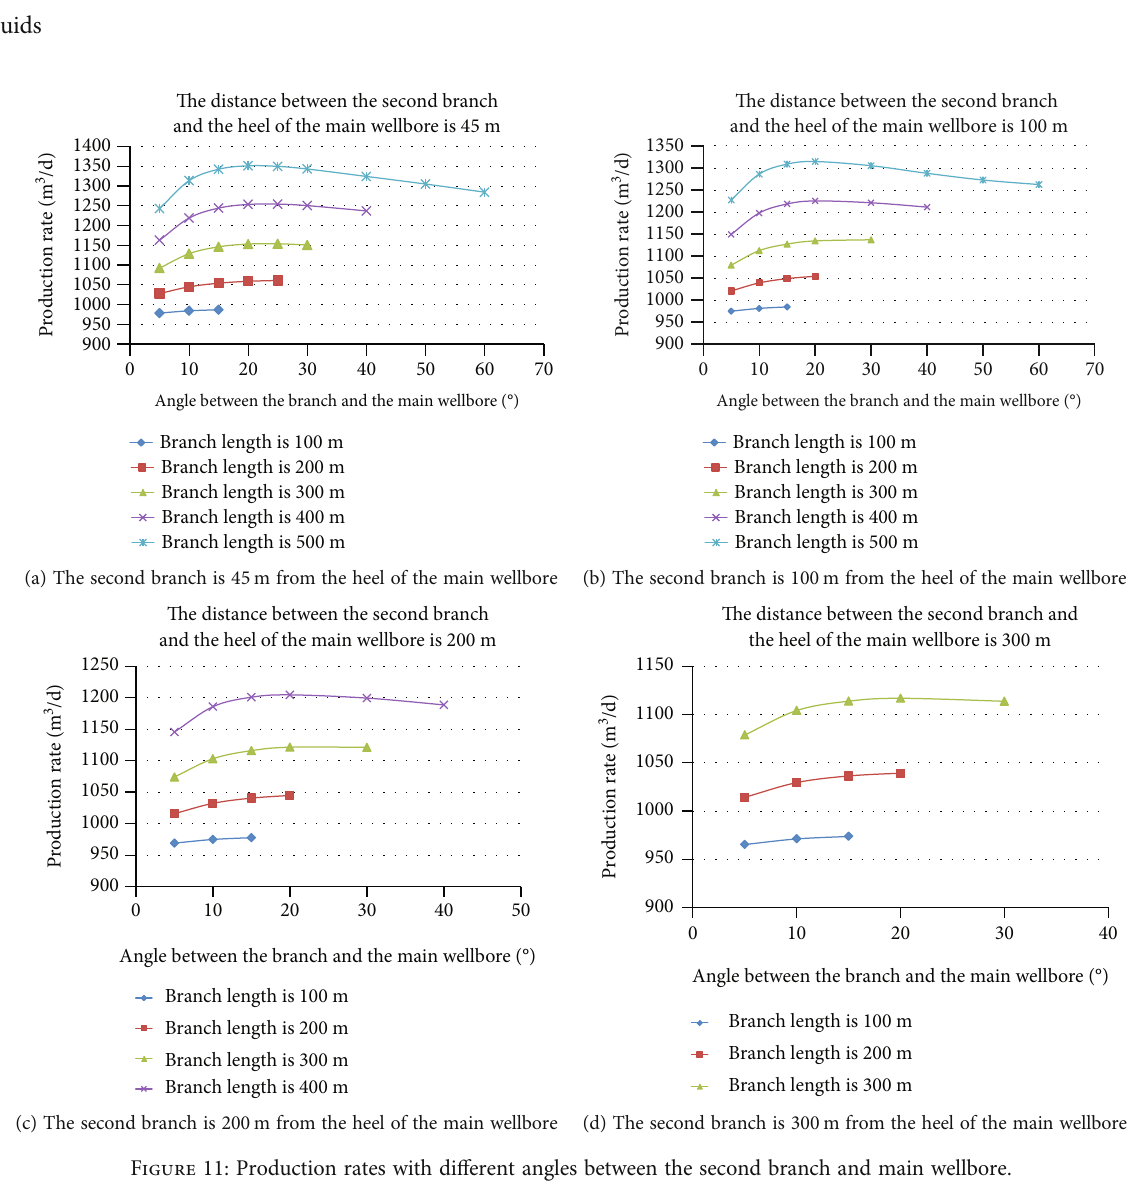
Figure 11: Production rates with di ff erent angles between the second branch and main